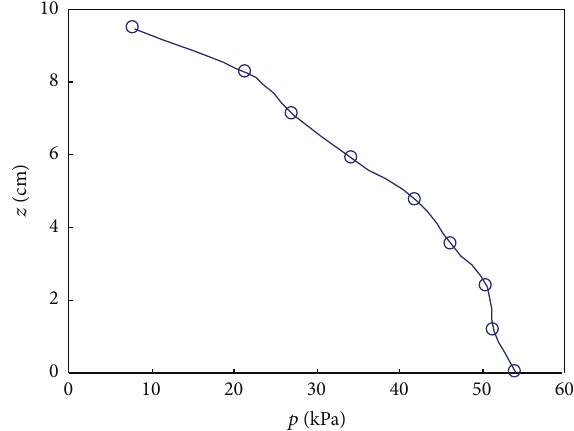
Figure 15: Earth pressure on the pile by numerical analysis. p : earth